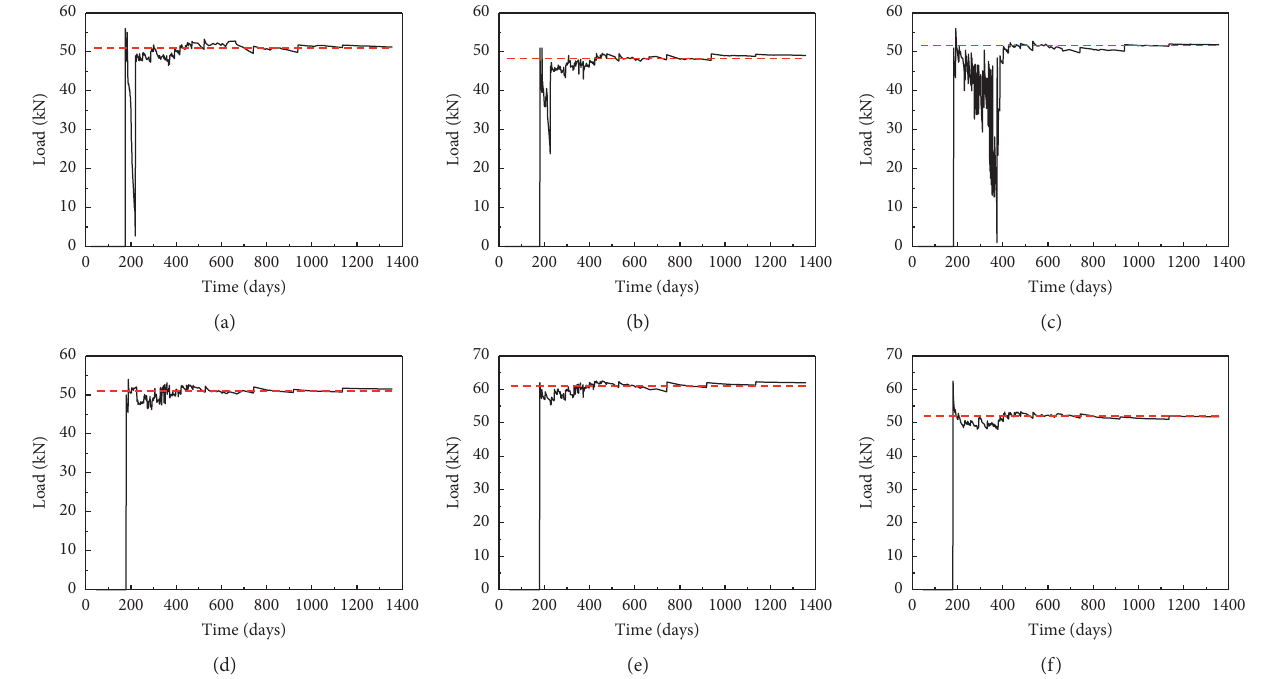
Figure 3: Loading histories of the test beams: (a) PC1; (b) PC2; (c) PC3; (d) PC4; (e) PC5; (f)